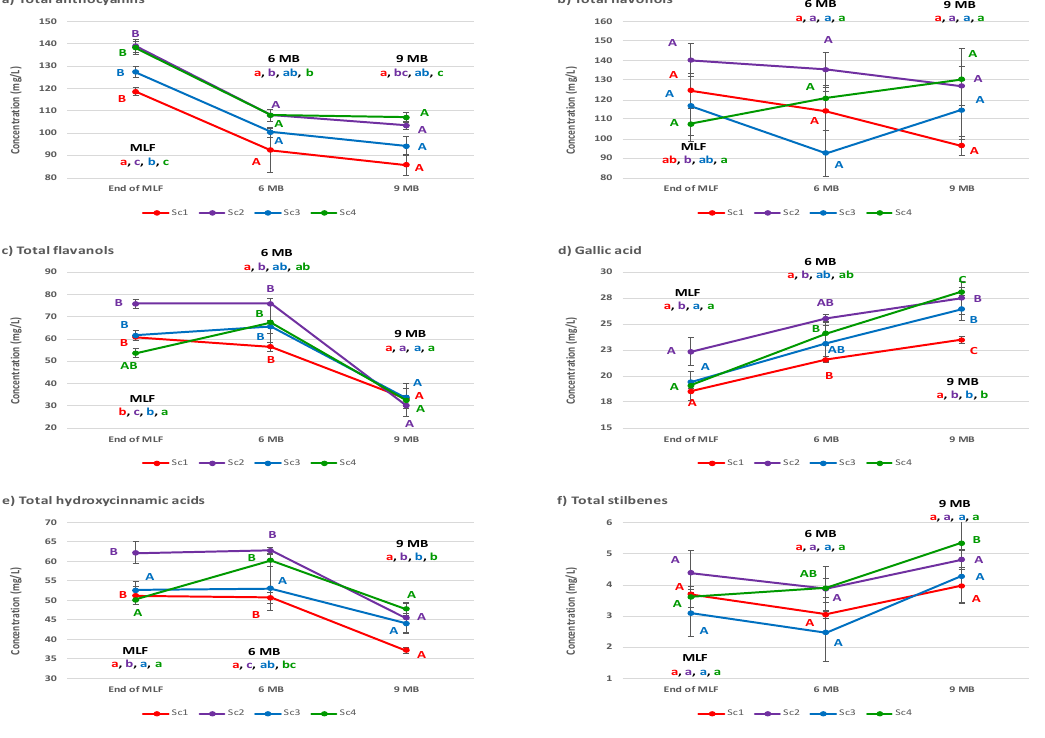
Figure 4. Phenolic compounds concentration (mg/L) of the wines at the end of malolactic fermenta- tion (MLF) and after 6 and 9 months of aging in bottles, 6 MB and 9 MB, respectively. All parameters are given as average values ± SD (n = 2). For each yeast, different capital letters indicate significant differences (Duncan test at p ≤ 0.05) between aging moments. For each moment, different lowercase letters indicate significant differences (Duncan test at p ≤ 0.05) between wines elaborated with the 4